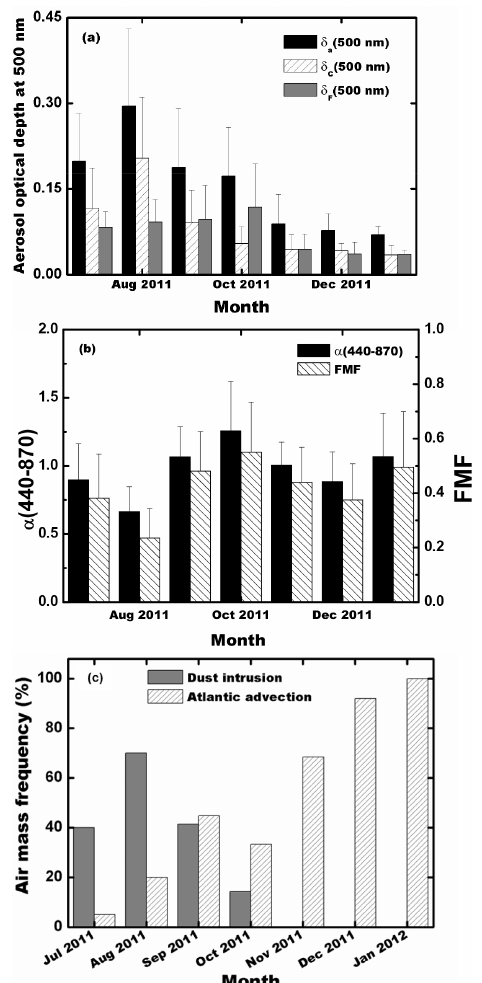
Figure 5. Monthly variations of (a) total, coarse and fine mode op- tical depths at 500nm and (b) fine mode fraction and Ångstrom exponent in the range 440–870nm obtained at Alborán Island from July 2011 to January 2012. The error bars are standard deviations. (c) Monthly relative frequency of Saharan dust intrusions and At- lantic air mass advections over Alborán Island from July 2011 to January 2012.